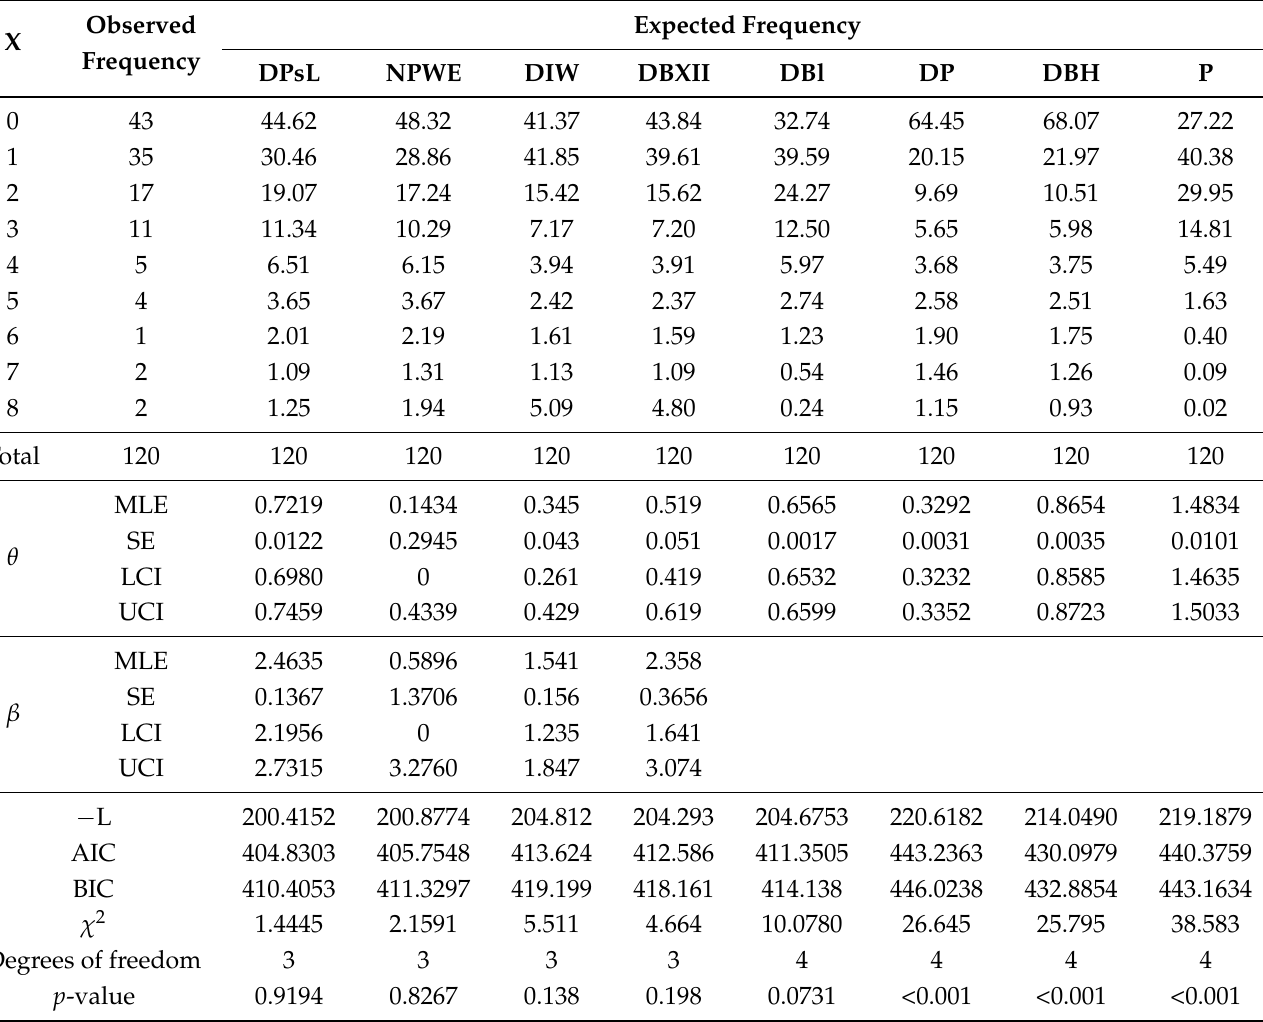
Table 11. The MLE, LCI, UCI, − L, AIC, BIC, χ 2 and p -values for the one parameter distributions considered using the number of borers